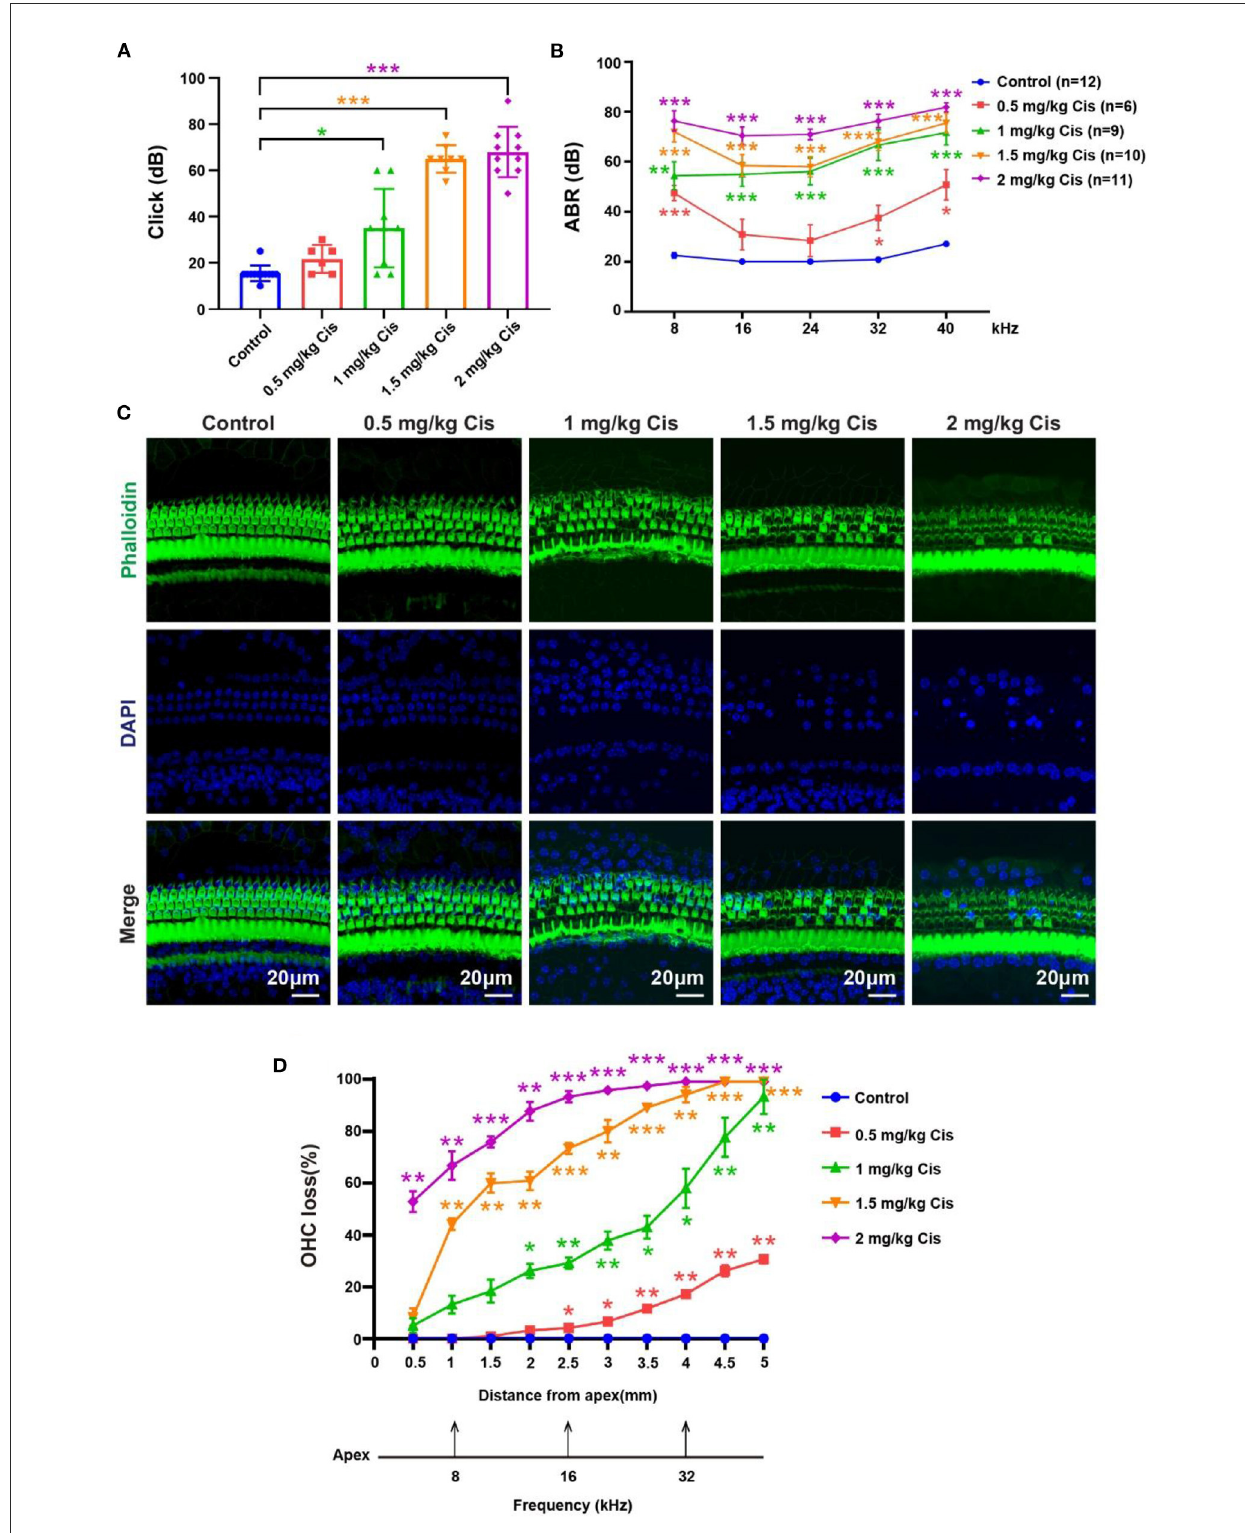
FIGURE1 Results of the hearing loss model treated with different cisplatin concentrations. (A) Statistical scatter plot of the click ABR. (B) Statistical line chart of the tone burst ABR. (C) Immunofluorescence staining with phalloidin and DAPI in the cochlea. (D) Quantification of the immunofluorescence staining in the cochlea. * p < 0.05, ** p < 0.01, *** p <